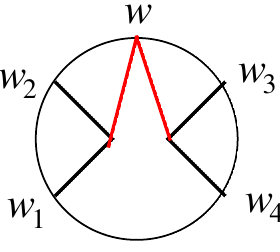
Figure 7 . Schematic diagram for the massless exchange residue in AdS 3